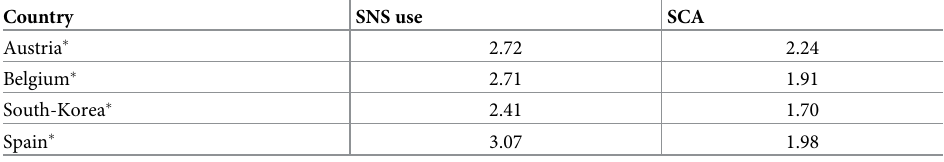
Table 6. Social media use (SNS use) and self-centered appearance focused use of social media (SCA) for each country.